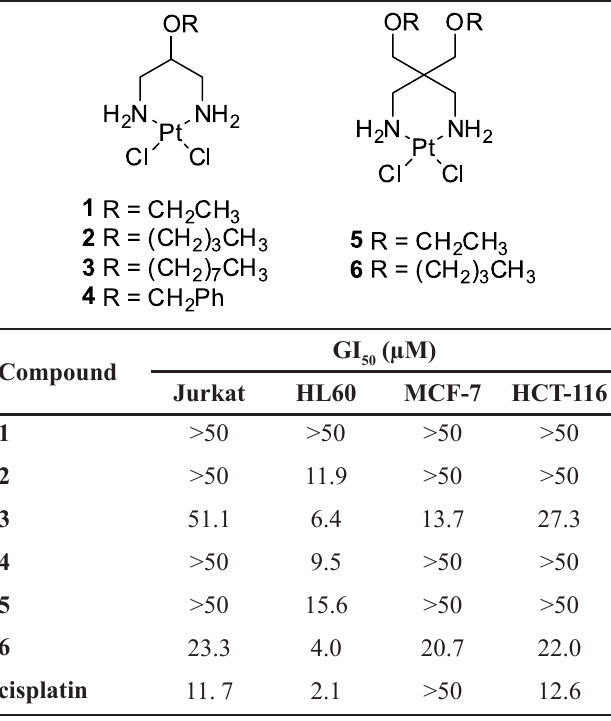
TABLE I - Effects of platinum complexes 1 - 6 on the growth